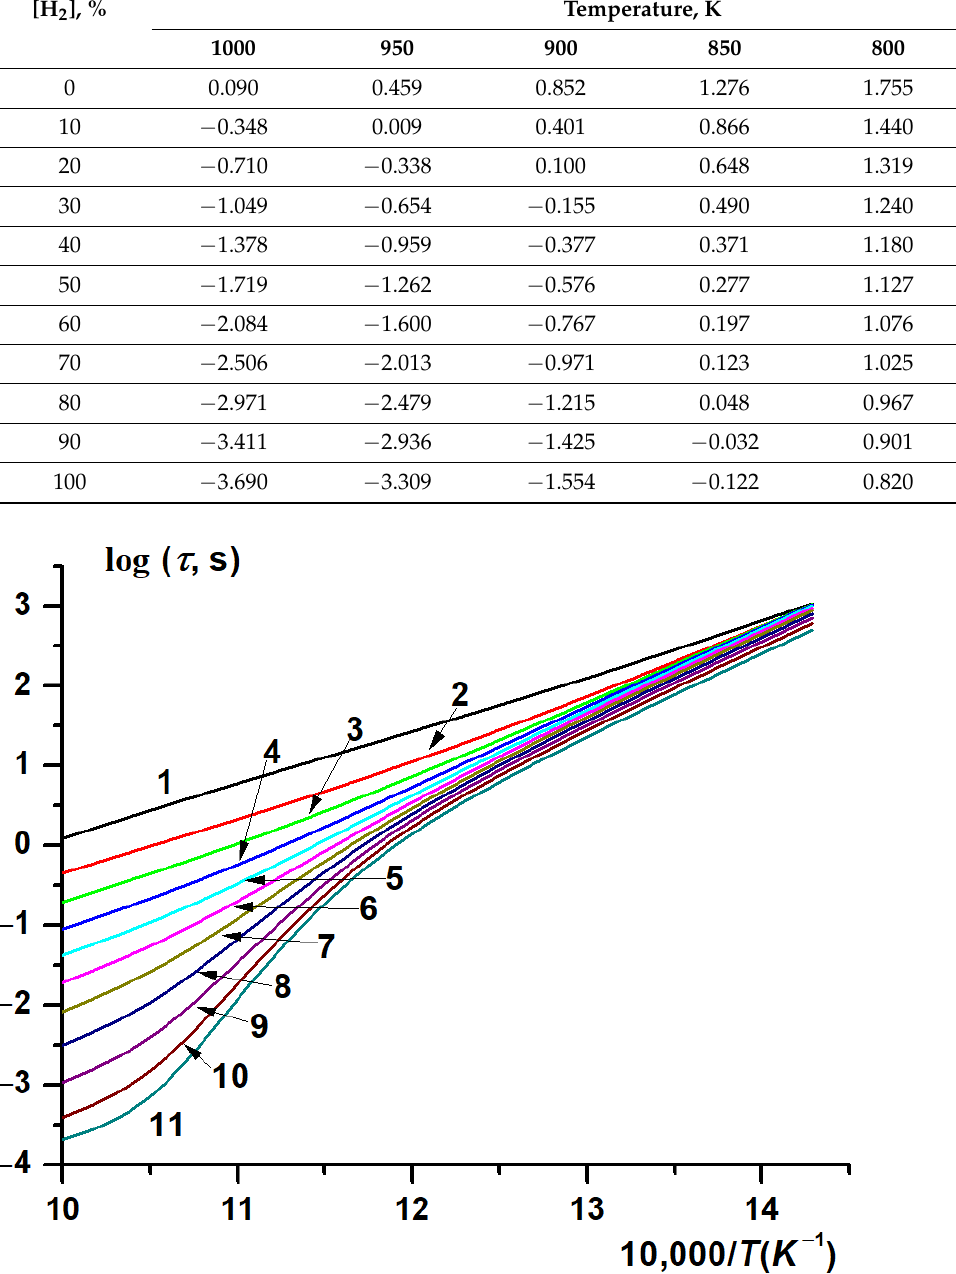
Figure 4. Calculated temperature dependence of the autoignition delay time of stoichiometric CH 4 - H 2 -air mixtures on the initial temperature at different concentrations [H 2 ] (%): 0 ( 1 ), 10 ( 2 ), 20 ( 3 ), 30 ( 4 ), 40 ( 5 ), 50 ( 6 ), 60 ( 7 ), 70 ( 8 ), 80 ( 9 ), 90 ( 10 ), 100 ( 11 ). P 0 = 1 atm.